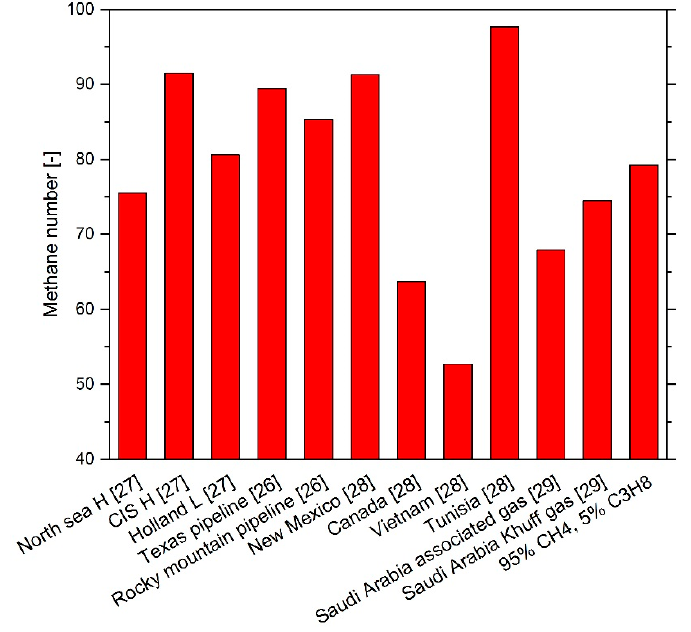
Figure 2. Methane numbers of various natural gases from different extraction areas.